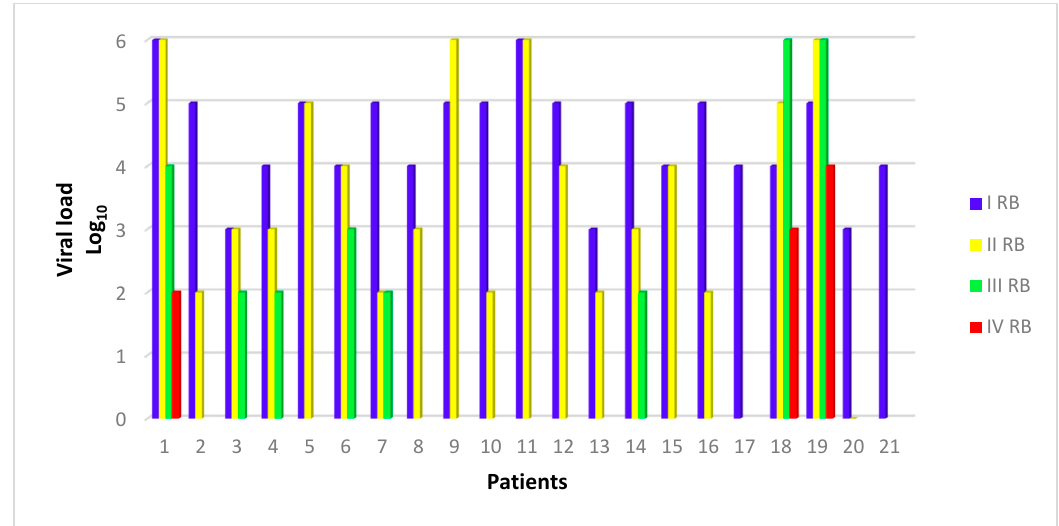
Figure 1. Renal biopsy (RB) and concomitant viral load (expressed as Log 10 copies/mL). Number of